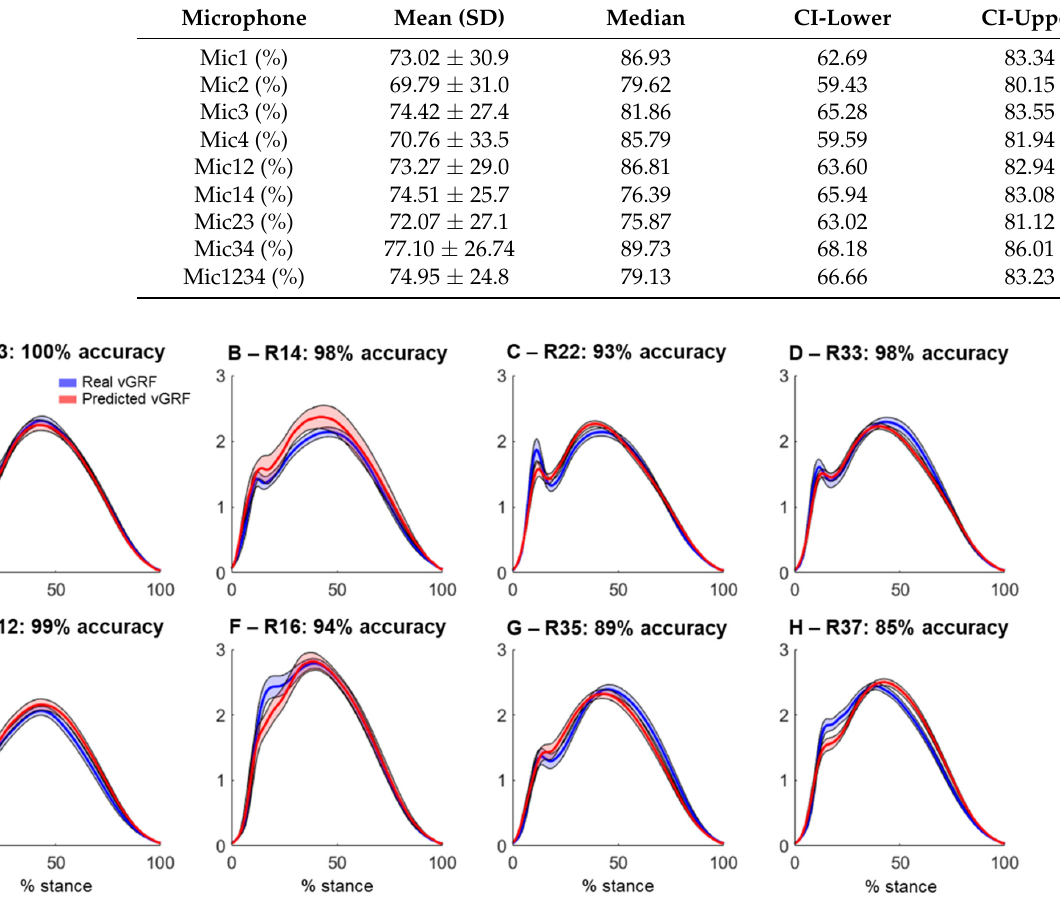
Table 1. Descriptive statistics from the accuracy in predicting running style using vertical ground reaction forces generated from sound data (% of total predictions). SD = standard deviation; CI-lower = lower bound of the 95% confidence interval; CI-upper = upper bound of the 95% confidence interval.